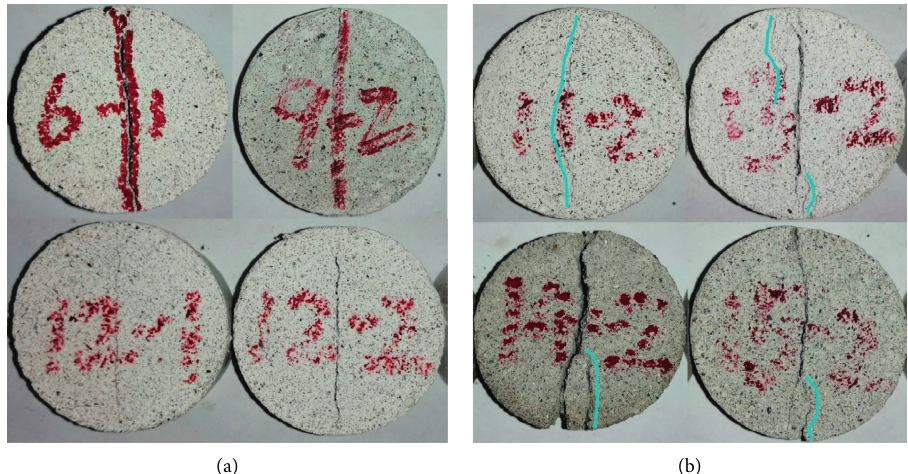
Figure 12: Splitting failure modes: (a) typical splitting failure mode; (b) untypical splitting failure mode.